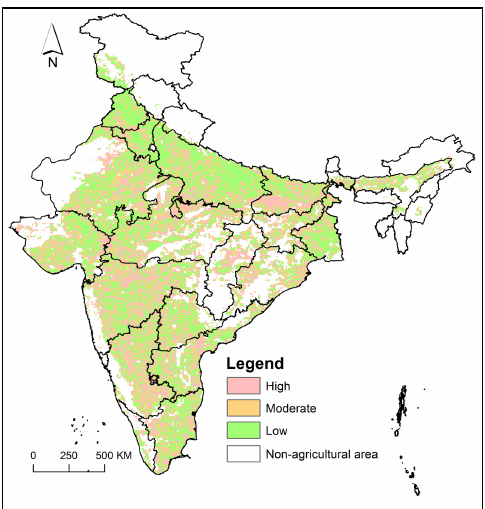
Figure 19 Vulnerability Map of Agricultural Drought During 1993- 2002.